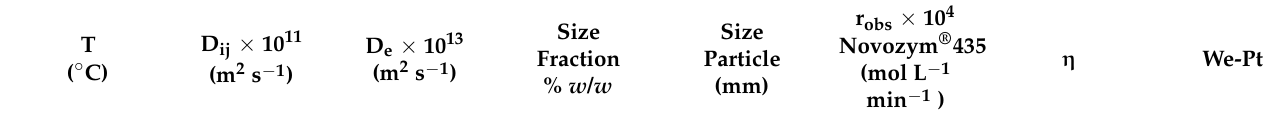
Table 3. Values of effective diffusion coefficient (D ij ), effectiveness factor (D e ), and Weisz–Prater criterion at 50 and 70 ◦